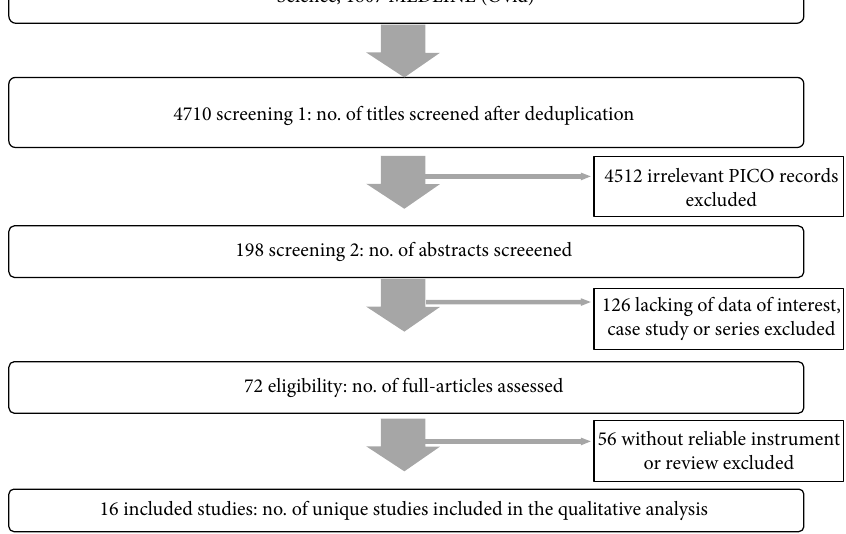
Figure 1: Preferred Reporting Items for Systematic Reviews and Meta-Analyses (PRISMA) Flow Diagram of the Systematic Literature Search and Review Protocol. NCBI: National Center for Biotechnology Information; PICO: population, injury, or